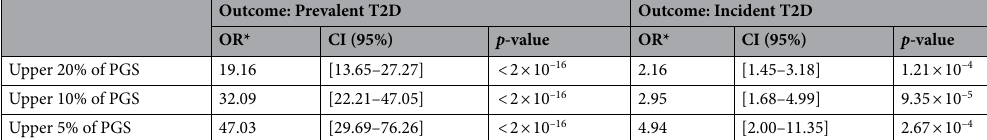
Table 3. Results of Logistic regression models of the effect of PGS cut-offs on risk of prevalent and incident diabetes. All models were adjusted for age, sex, BMI, physical activity and FamRS. *OR is given for those above this cut-off with the remainder of the population as the reference.